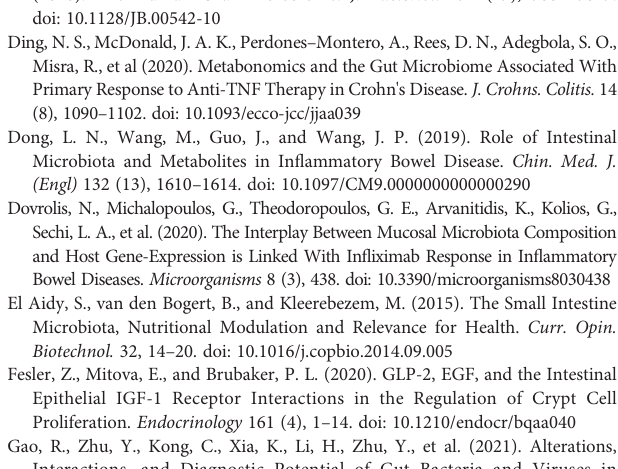
Supplementary Figure 1 | Structure analysis of the ileal microbiota in patients with CD. (A, B) Chao diversity index of phylum level and genus level in the ileal samples. (C, D) Shannon diversity index of phylum level and genus level in the ileal samples. (E, F) Venn diagram indicating the overlap of OTUs in the categories on the phylum level and genus level, respectively. Supplementary Figure 2 | COG functional classi fi cations of microbiota in patients with CD. (A – C) COG functional classi fi cations of microbiota in the oral cavity, sputum and ileum,